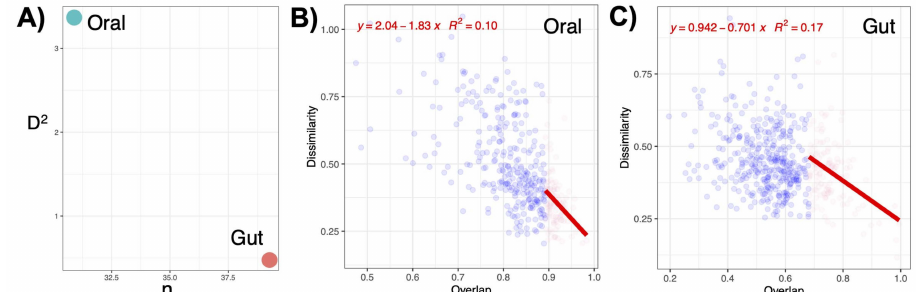
Figure 7. Complexity–stability relationship of oral and gut communities ( A ) where the effective connectance D 2 is calculated based on fitting a linear regression to top dissimilarity/overlap values for pair-wise samples where the overlap values are in top 25% of communities, and then recovering D 2 as the slope of fitted regression for oral ( B ) and gut ( C )